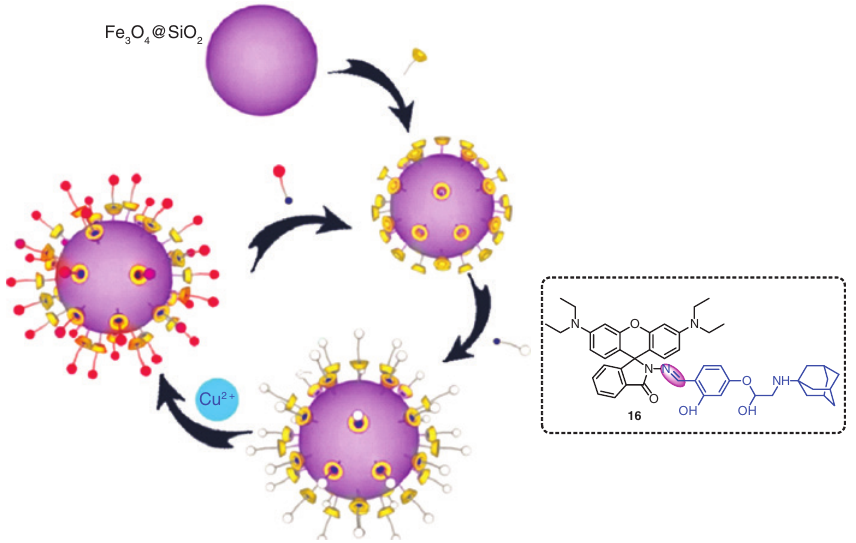
Figure 13: Chemical and schematic illustration of the preparation of SFIC MNPs probe 16 for Cu 2 +